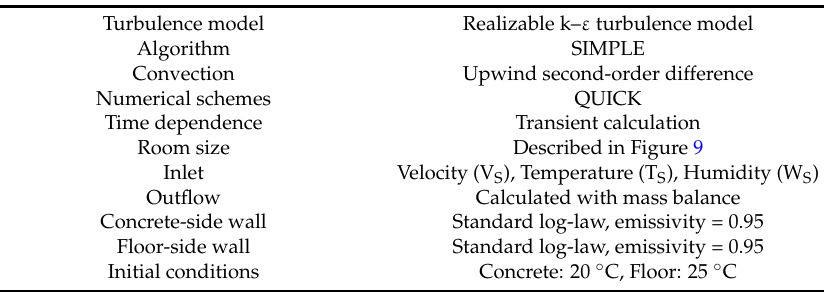
Table 3. Boundary and calculation conditions.